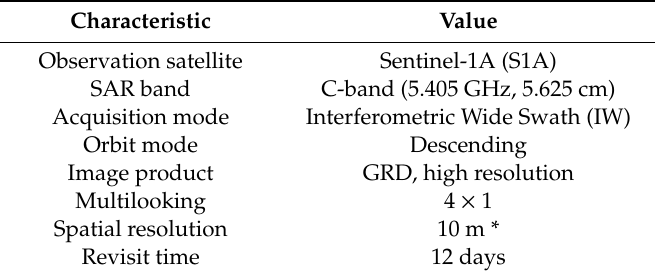
Table 3. Main characteristics of the SAR data during the